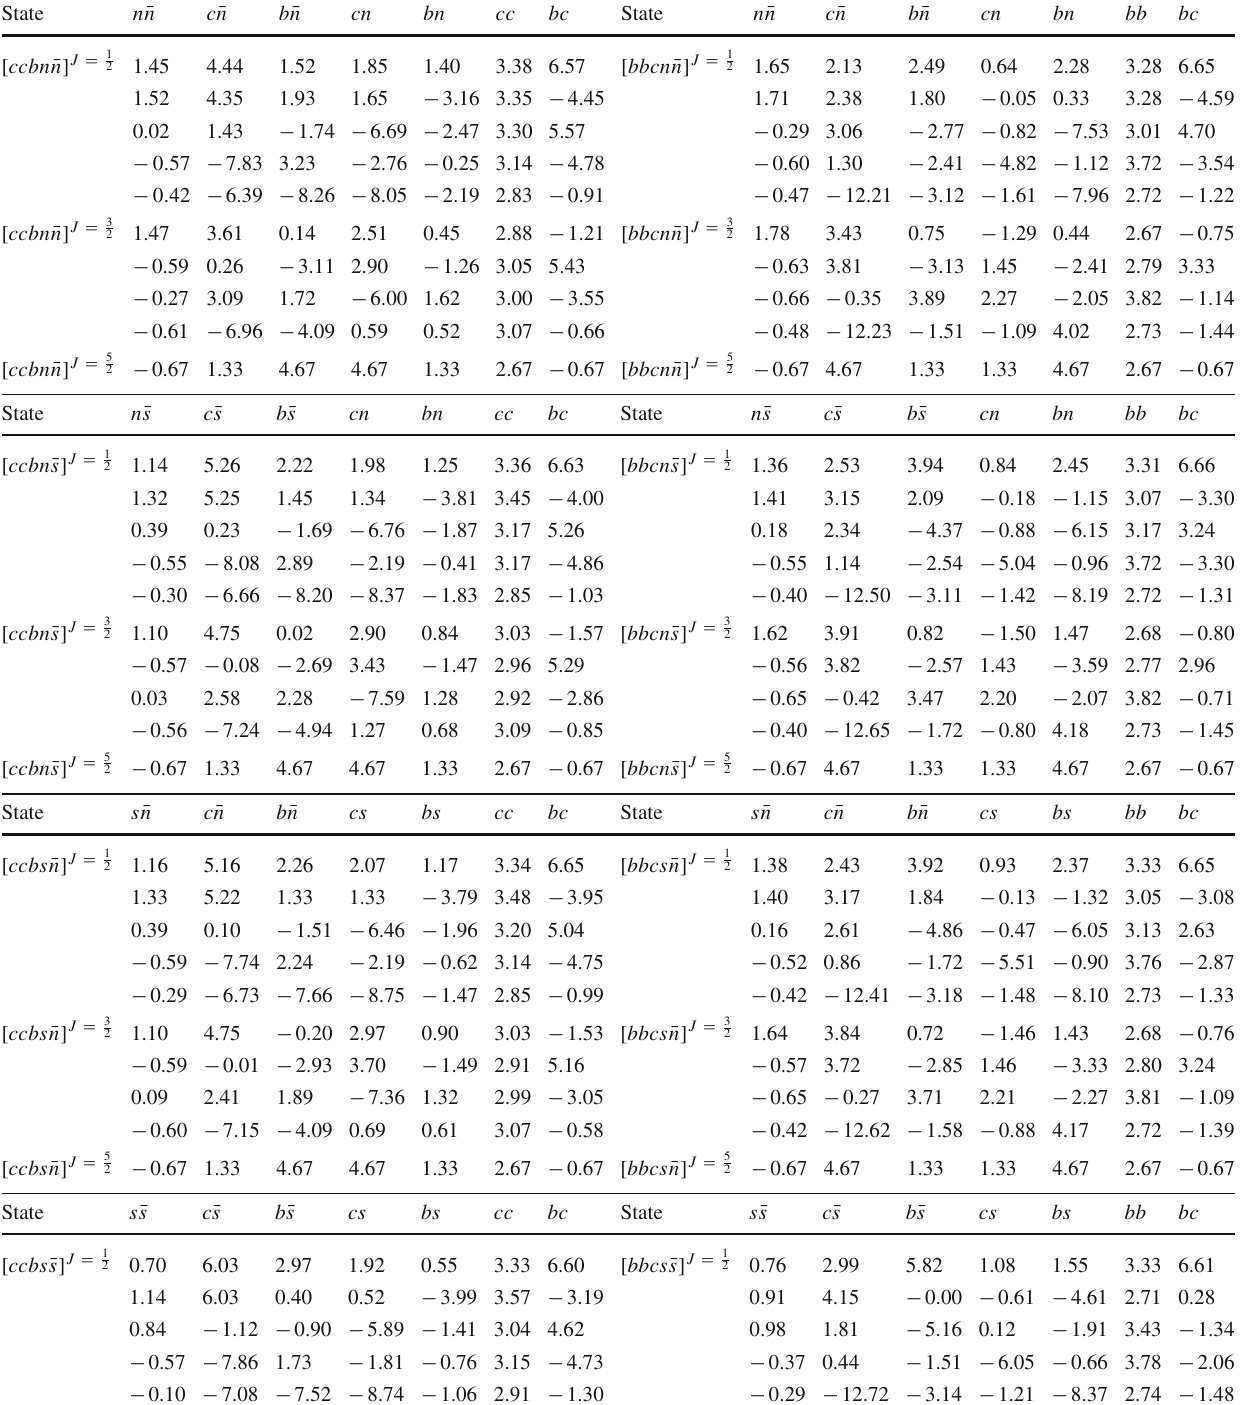
Table 10 Values of K ij when reducing the coupling strength C ij between the i th and j th quark components by 0.001%. The orders of states are the same as those in Tables 7 and 8